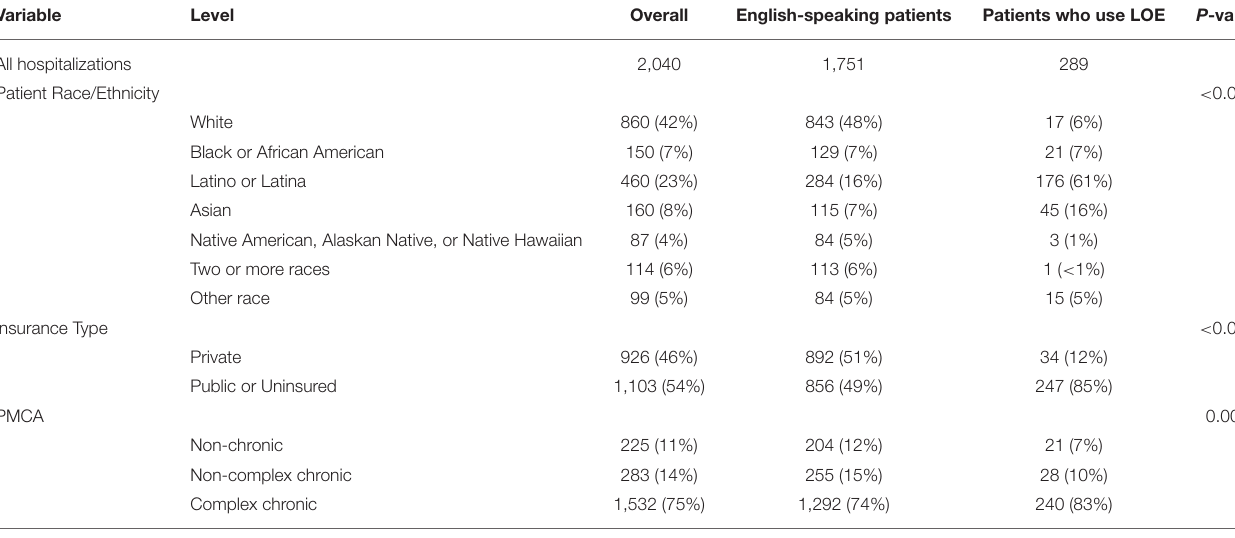
TABLE 1 | Demographics of 2,040 hospitalizations during the study period. Variable